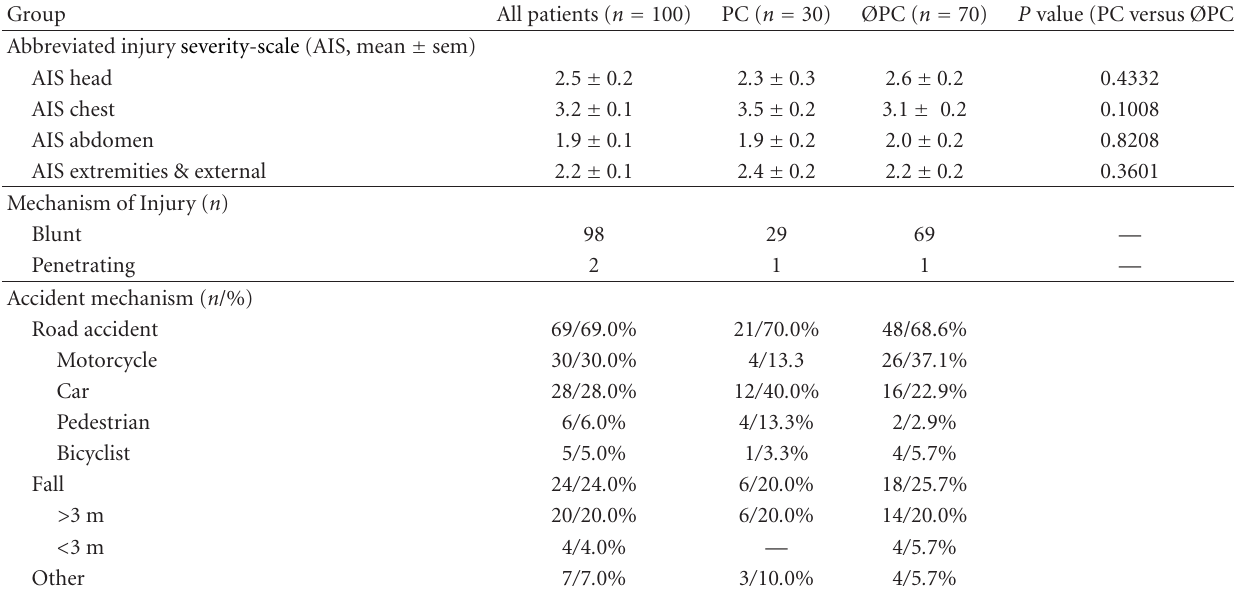
Table 2: Overview of type and mechanisms of injuries within the two investigated groups groups (ØPC: no pulmonary complications, PC: pulmonary complications and ctrl, data are presented as mean ±